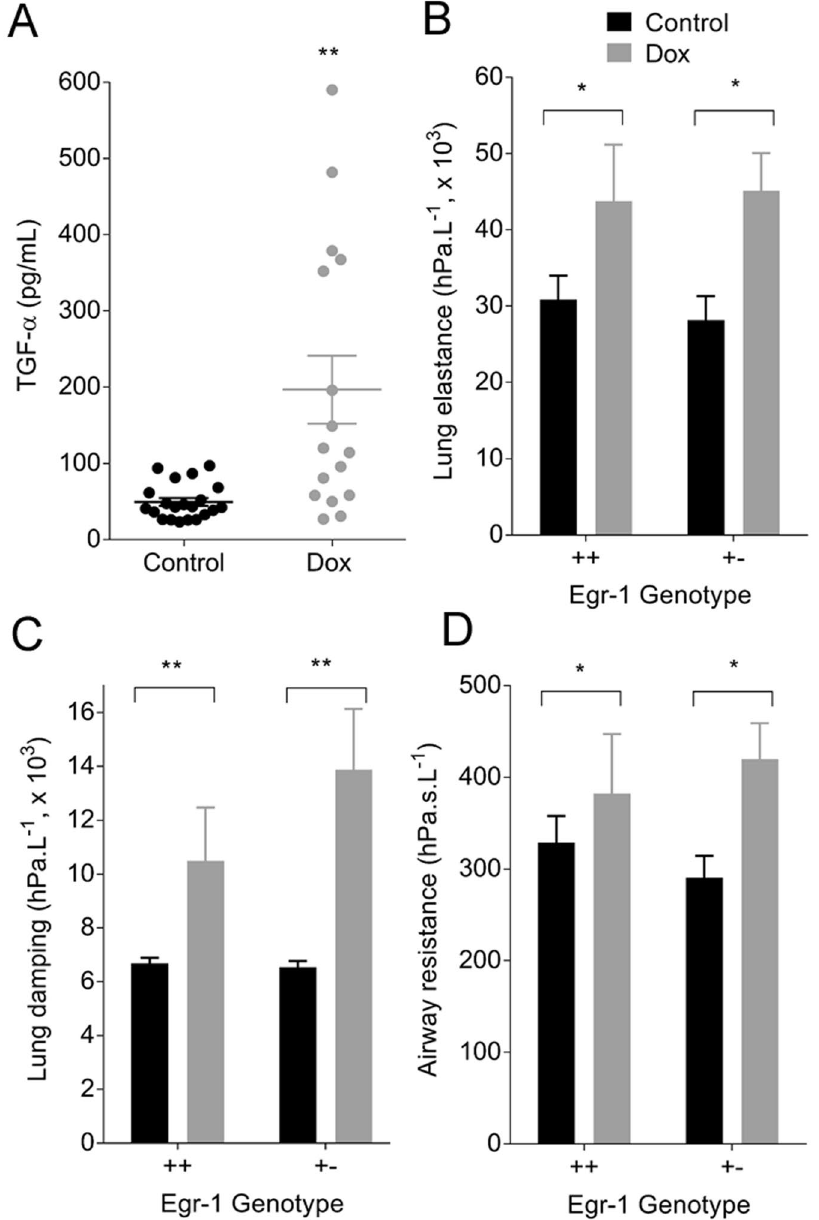
Figure 1. Dox induced TGF- α overexpression ( A , Control n = 21; Dox n = 16; ** p < 0.01) and increased lung elastance ( B , * p < 0.05), lung damping ( C , *** p < 0.01) and airway resistance ( D , * p < 0.05) compared with the Control group. There was no effect of genotype. Data are mean ± SE; Egr-1 ++ Control n = 7, Dox n = 7; Egr- 1 +− Control n = 7, Dox n = 12.